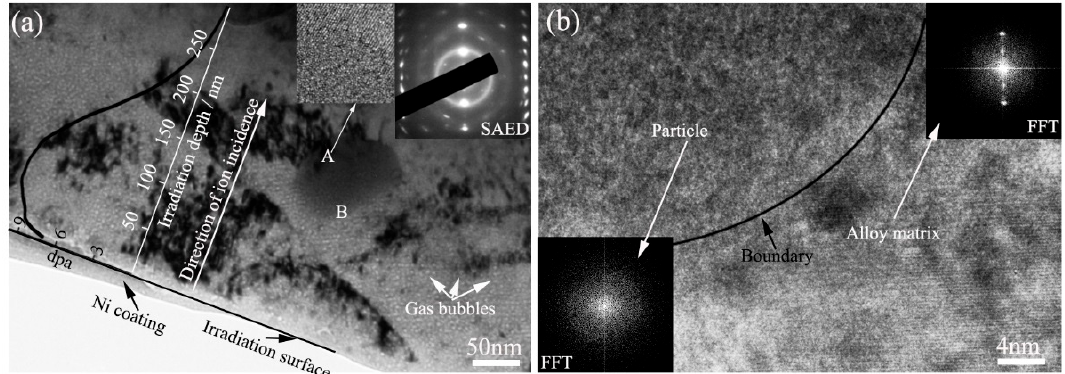
Figure 3 TEM bright field images showing the microstructure of Zr alloy #1 irradiated with 2.86 × 10 15 Kr + /cm 2 fluence at 320 °C. ( a ) Under-focused bright field image; ( b ) High-resolution TEM (HRTEM) image showing the boundary area between a particle and the Zr alloy matrix.